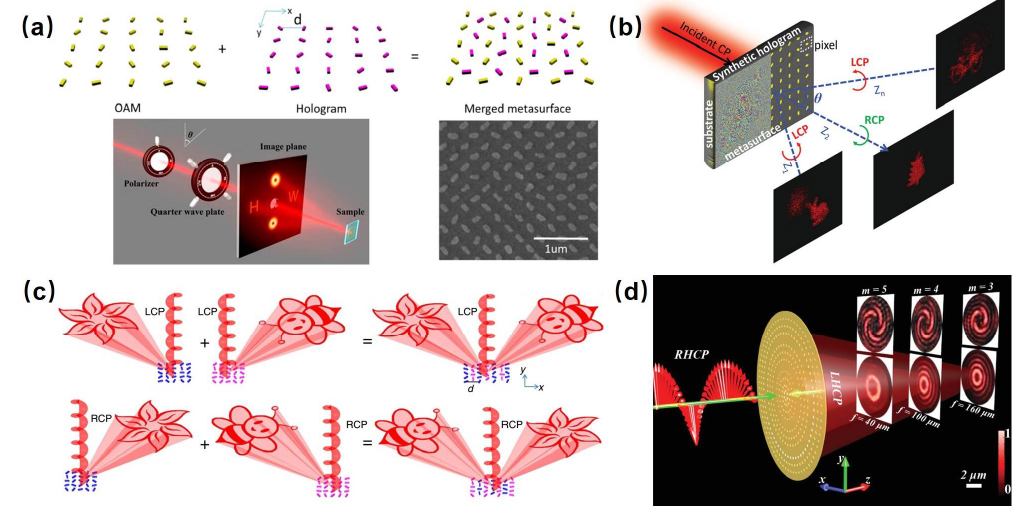
Figure 1. Multifunctional devices designed with merged structures. ( a ) Design strategy, sample picture, and experimental characterizations of a multifunctional metasurface than can generate holographic images or a vortex beam depending on the helicity of incident circularly polarized light. Reproduced from Ref. [74] with permission. ( b ) A metasurface that can reconstruct different images to different polarization channels. Reproduced from [64] with permission. ( c ) A metasurface that can generate multiple hologram images as shined by circularly polarized light with different helicity. Reproduced from [63] with permission. ( d ) A metasurface that can generate optical vortices with distinct topological charges at different longitudinal focal planes. Reproduced from [58] with permission. LCP, left CP; RCP, right CP; OAM, orbital angular momentum; LHCP, left-handed circularly polarized ; RHCP, right-handed circularly polarized.